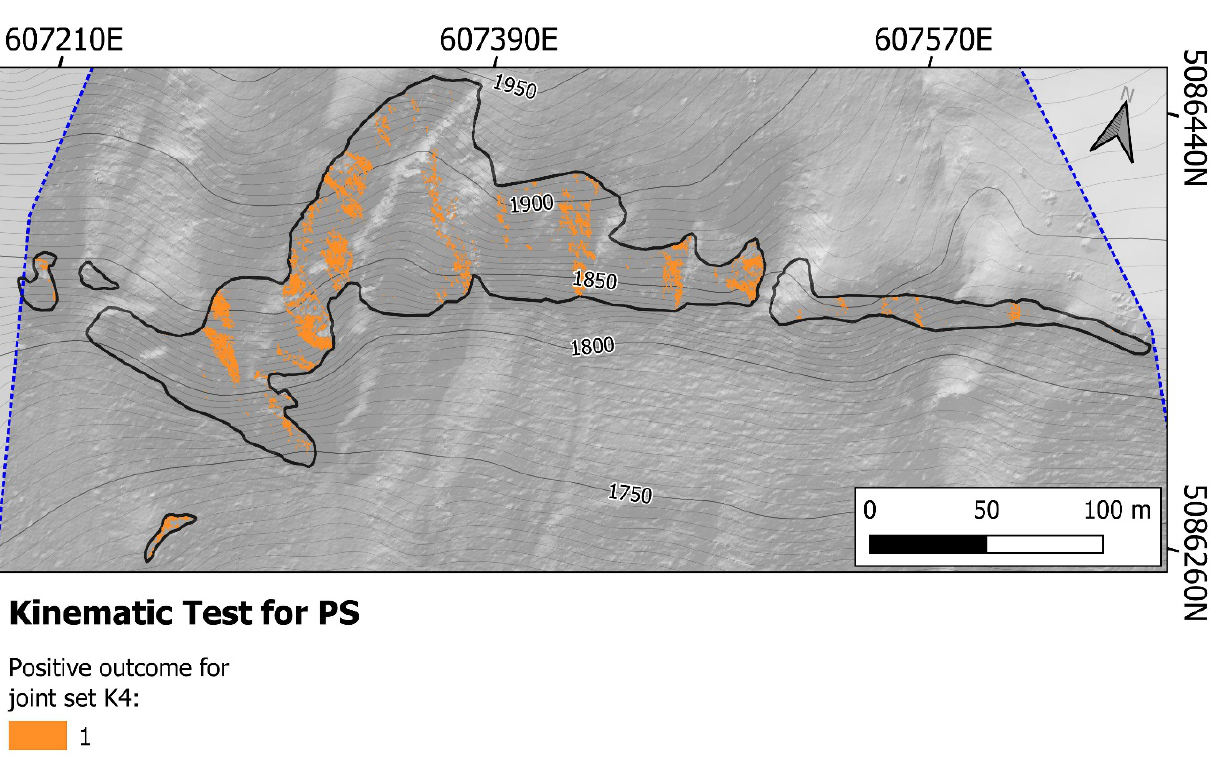
Figure A14. Image of the partial output file showing the kinematic test for TP performed considering only joint set K4.